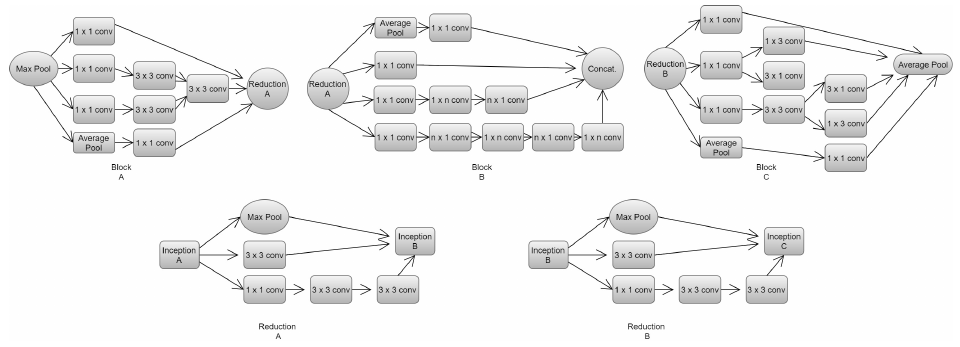
Figure 10. Inception blocks.